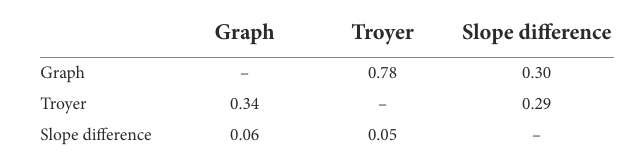
TABLE 2 Edge agreement of three